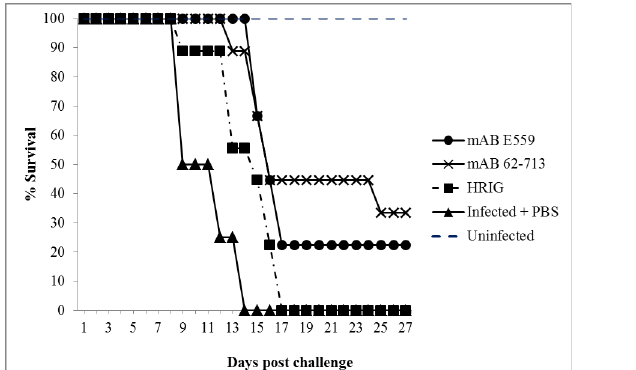
Fig 9. Hamster survival curve after infection with rabies virus and administration of PBS, RIG or mAbs. For infected and treated groups, 9 hamsters were in each group, while untreated control groups had 4